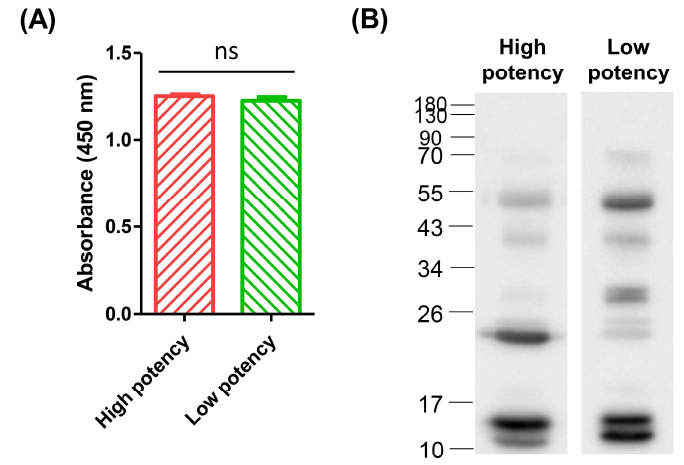
Figure 1. Immunoprofiles of high-potency and low-potency horse-plasma samples against whole D. acutus venom. ( A ) The venom of hundred-pace pit vipers was initially coated on the microplate and indirect ELISA was performed using high- and low-potency horse plasma as primary antibodies. Each bar represents means ± SD of triplicates (ns: not significant). ( B ) Western blot analysis of the proteins involved in immune reactions of both horse-plasma samples against whole venom. The densitometry intensity ratio of each band is shown in Supplementary Materials Table S1.